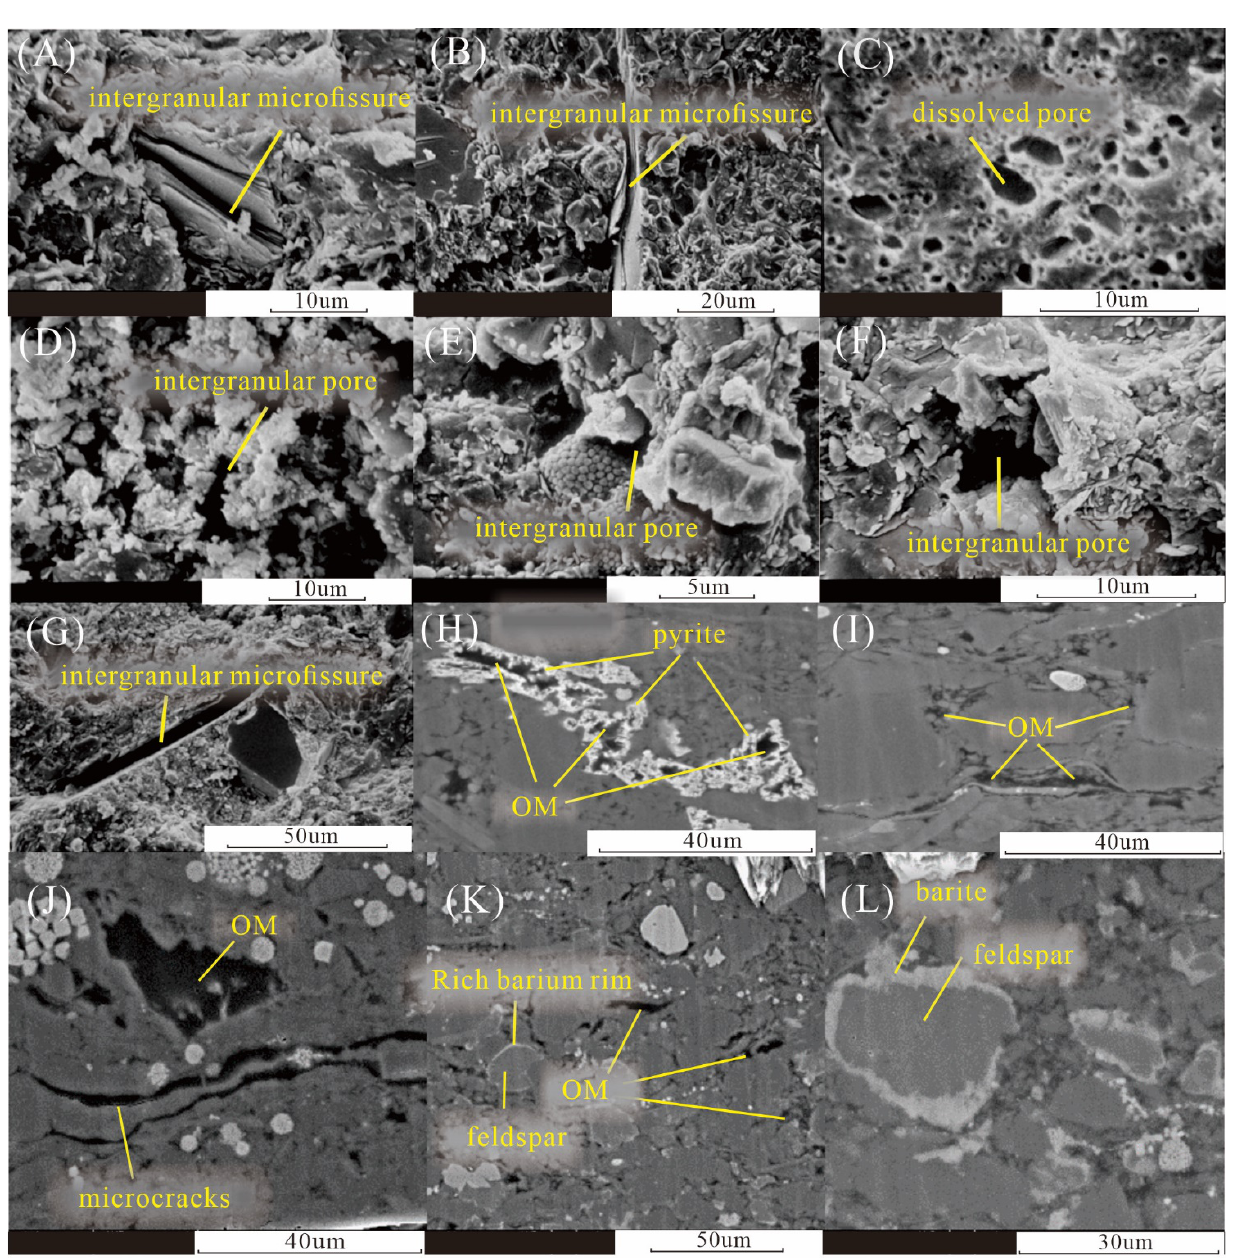
Figure 5. Scanning electron microscopy characteristics of pores in shales of the Wufeng-Longmaxi and Niutitang Formations in northern Guizhou Province. ( A , B , G ) Intergranular microfractures of clay minerals, ( C ) calcite dissolution pores, ( D ) intergranular pores of mylonitic mineral grains, ( E ) intergranular pores of clay minerals partially filled with pyrite, ( F ) intergranular pores of clay minerals, ( H ) organic matter filled with pyrite, ( I ) intergranular pores plugged by organic matter and mud, ( J ) organic matter pores developed within organic matter, ( K ) organic matter uniformly distributed in intergranular micropores, and ( L ) feldspar particles surrounded by barite.